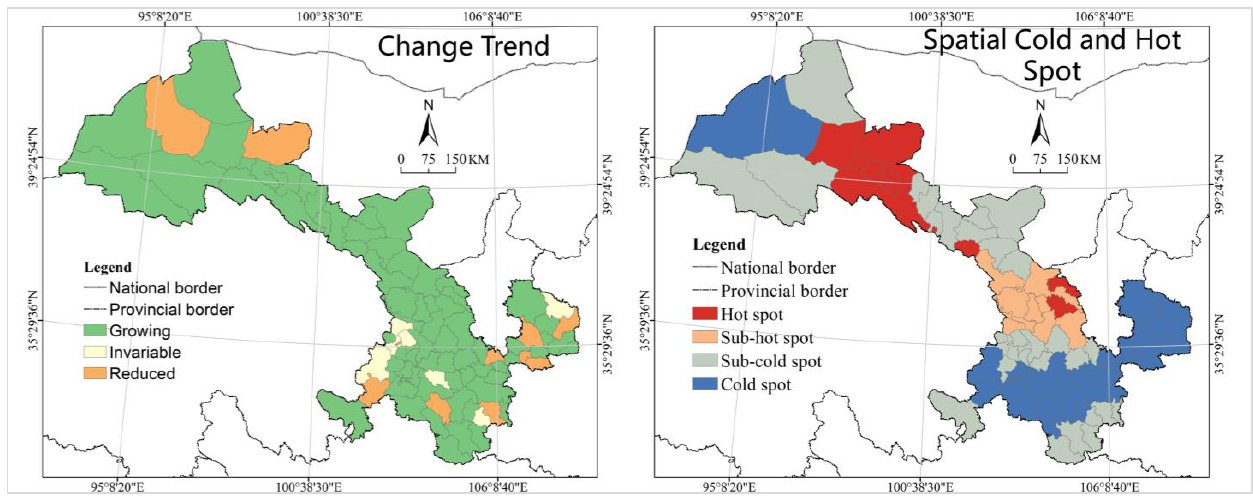
Figure 6. Analysis on the spatial cold and hot spot of urban construction land scale in Gansu. Figure 7. Analysis on the urban construction land change of Gansu.